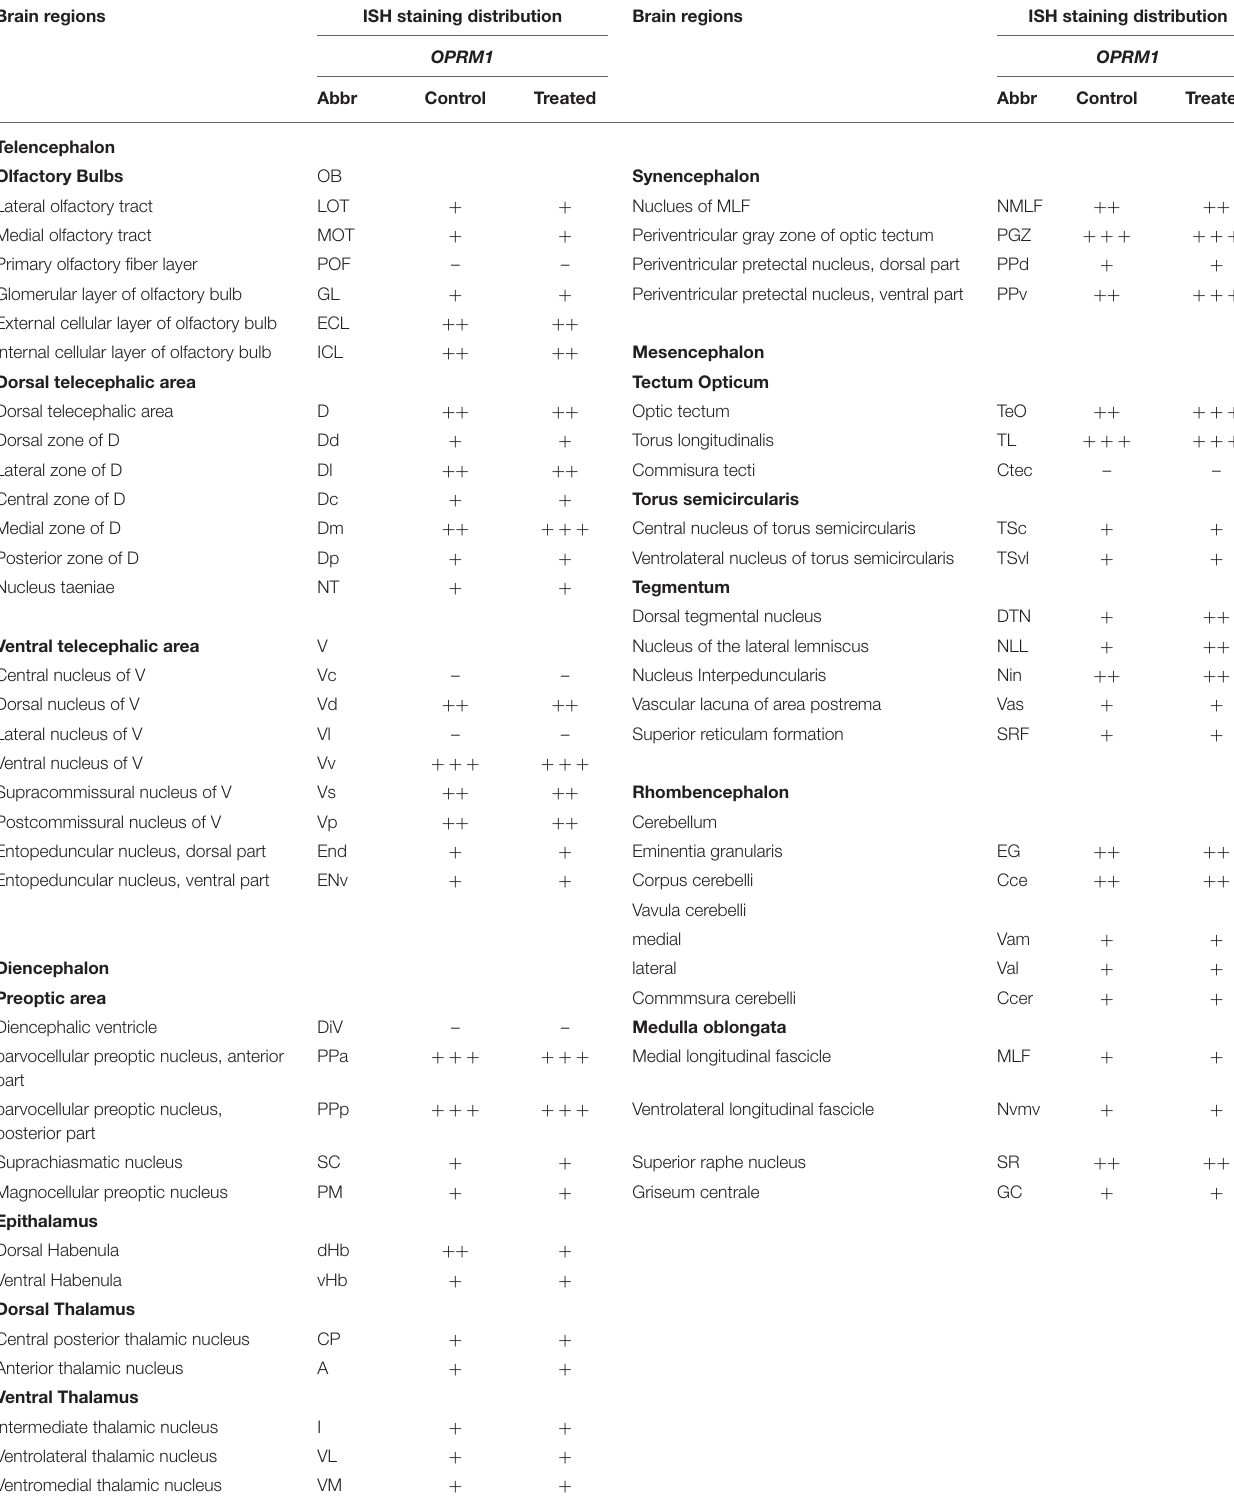
TABLE 1 | Expression of oprm1 mRNA in the brain of adult zebrafish. Brain